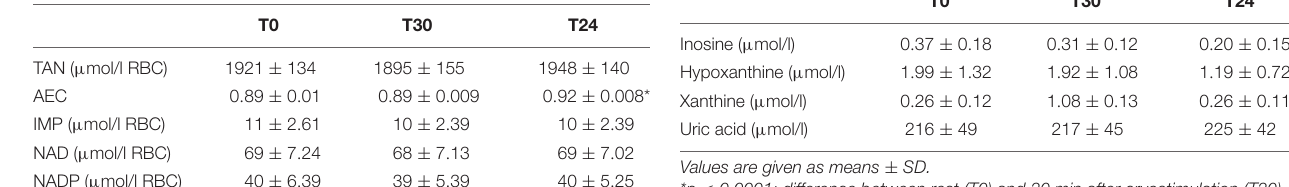
TABLE 2 | Total adenine nucleotide pool, adenylate energy charge and concentration of inosine and pyridine nucleotides in red blood cells before (T0); 30 min after (T30); 24 h after cryostimulation (T24).